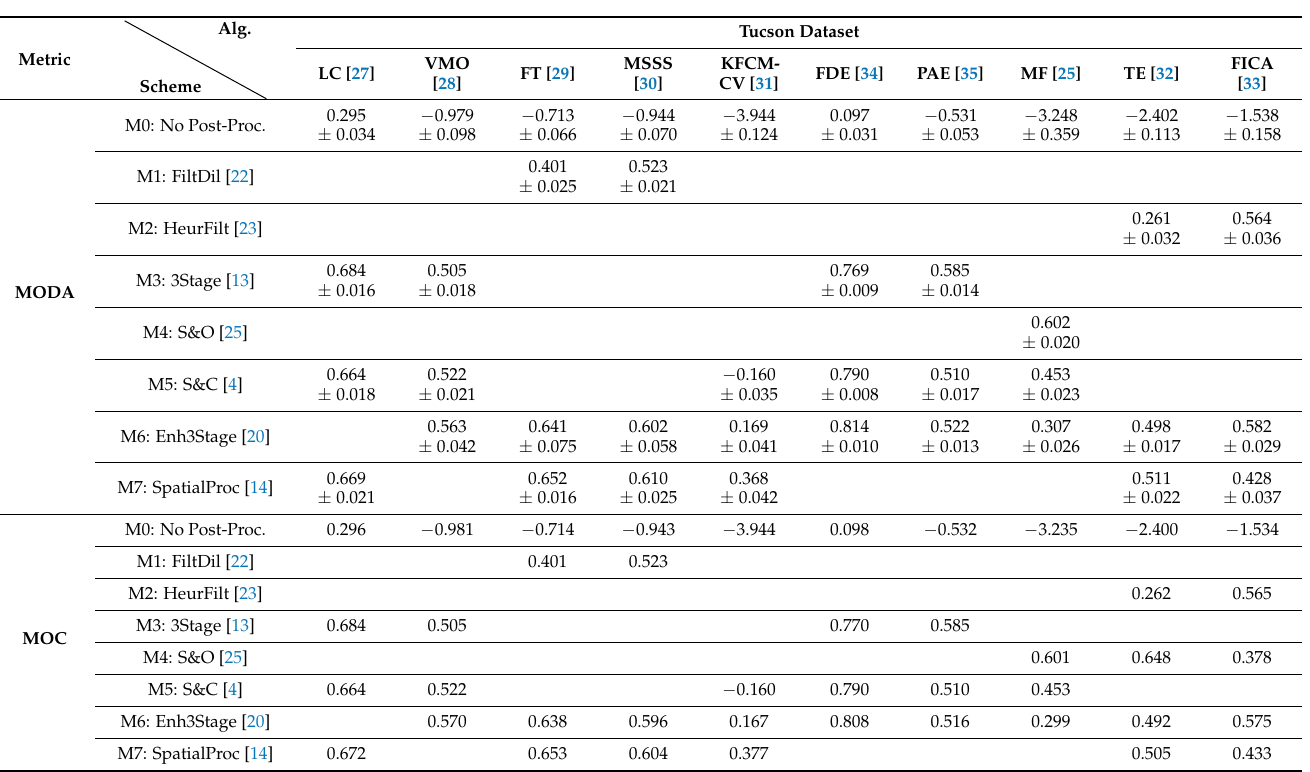
Table 6. MODA and MOC for ten algorithms before and after combining with their best three post-processing